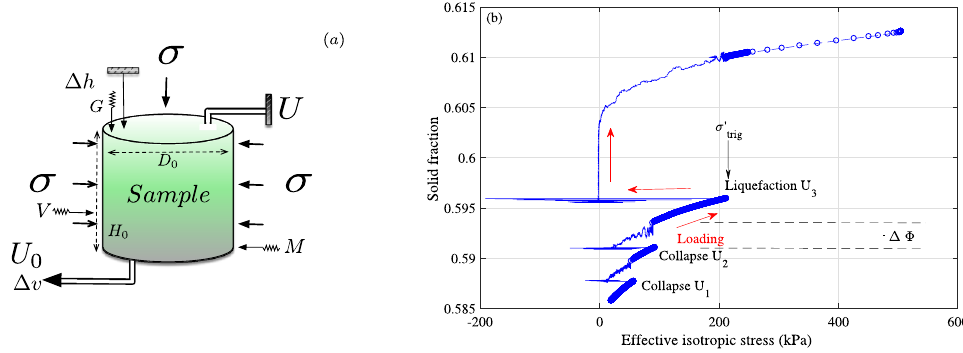
Figure 1. Dynamic instabilities of model granular materials in drained isotropic compression. ( a ) Sketch of the experimental setup of the drained isotropic compression on cylindrical sample inside a triaxial cell. The axial displacement (cid:31) h and the water volume (cid:31) v were measured to estimate the global axial strain ε a and solid fraction (cid:31) . The back pressure U 0 was applied at the sample bottom, while the measurements of static pore-water pressure U at the sample top permit to assess the homogeneity of the effective stress state. One piezoelectric accelerometer measures the vertical acceleration G of the sample top cap. One complementary non-contact portable laser vibrometer V and one microphone M record the lateral surface vibration and the radial sound pressure outside the triaxial chamber. ( b ) Collapses U 1 , U 2 and liquefaction U 3 in isotropic drained compression from 20 up to 212 kPa of confining pressure. Red arrows denote the direction of